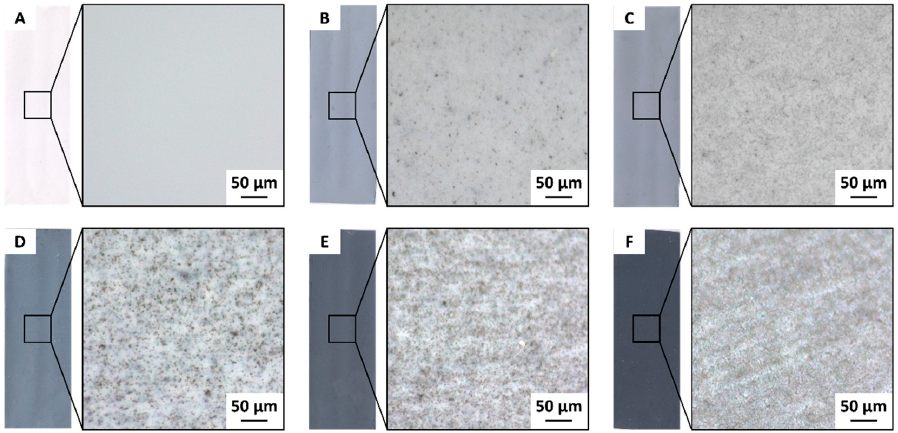
Figure 5. Real size (left) and optical microscopy images (right) of the surface of the 14.5 wt % PVDF membranes with ( A ) 0 wt % CB, ( B ) 0.5 wt % CB, ( C ) 1 wt % CB, ( D ) 2 wt % CB, ( E ) 5 wt % CB, and ( F ) 7.5 wt % CB.